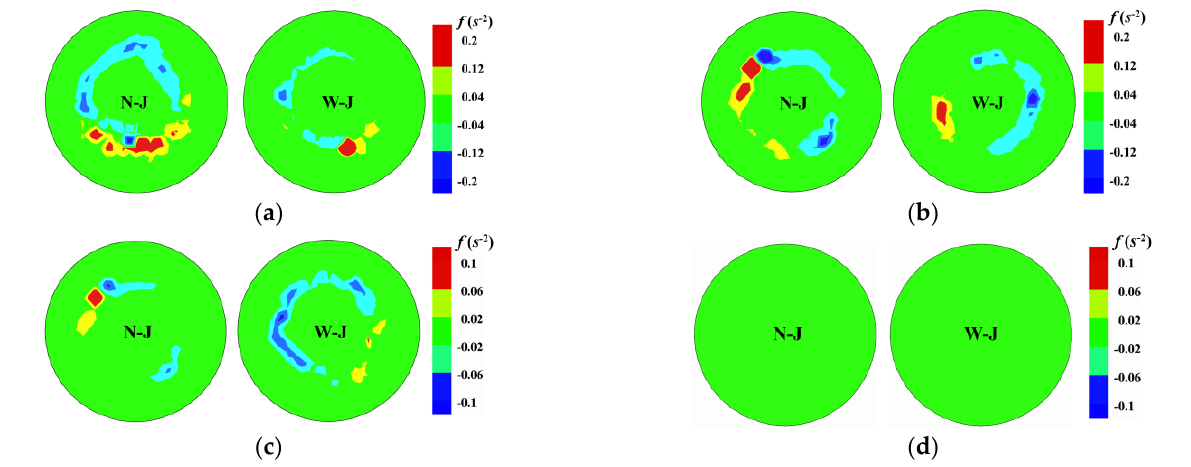
Figure 15. The transient distribution of vortex expansion ω ( ∇ · V ) on the monitoring surface TP1. ( a ) Q* = 53%, ( b ) Q* = 69%, ( c ) Q* = 84%, ( d ) Q* = 100%.